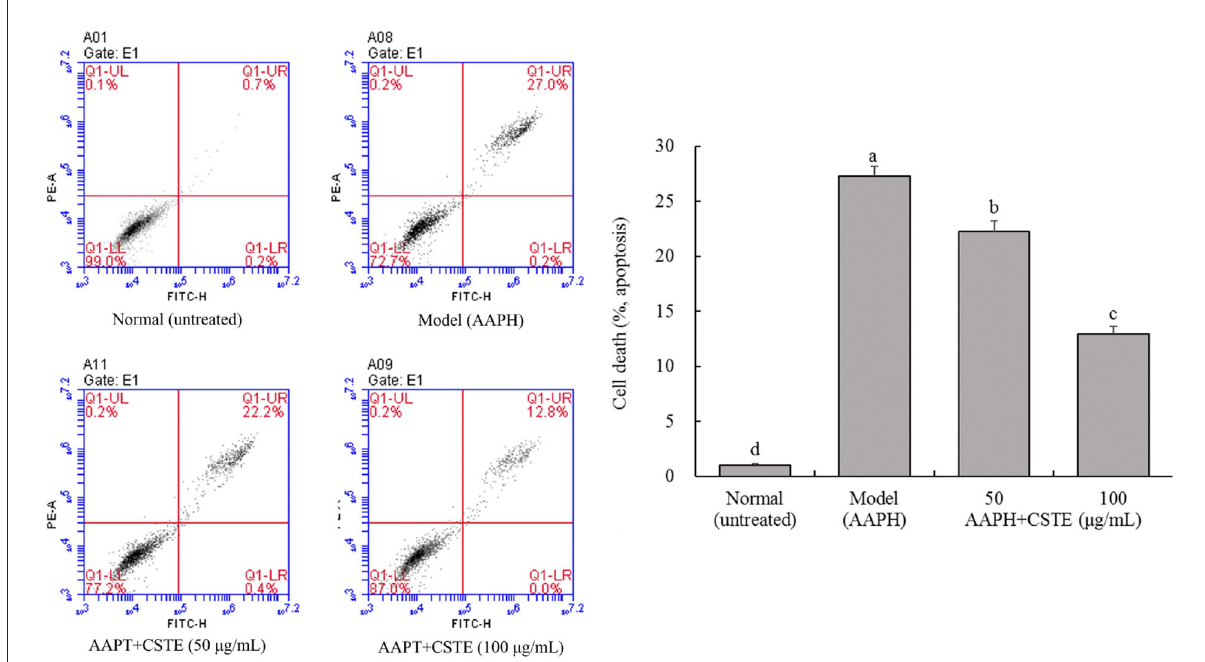
FIGURE6 Flow cytometry of apoptosis HL-1 cells, CSTE: Clerodendranthus spicatus (Thunb.) C. Y. Wu extract. a − d according to Duncan’s multi range test, the average values of different letters in the same column have significant differences ( P < 0.05, n =